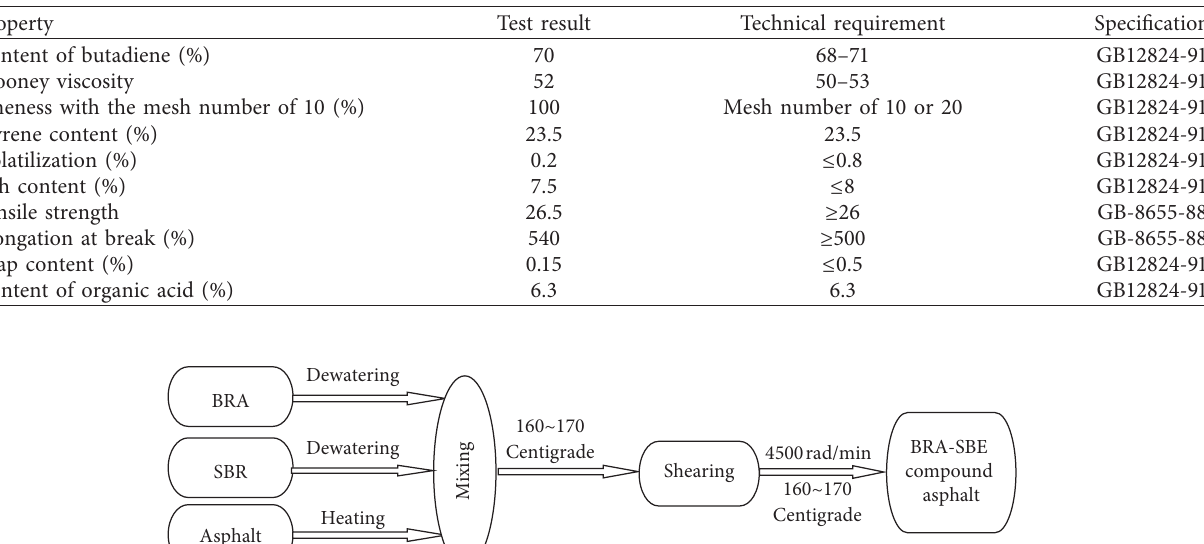
Table 3: Technical properties of SBR 1502.